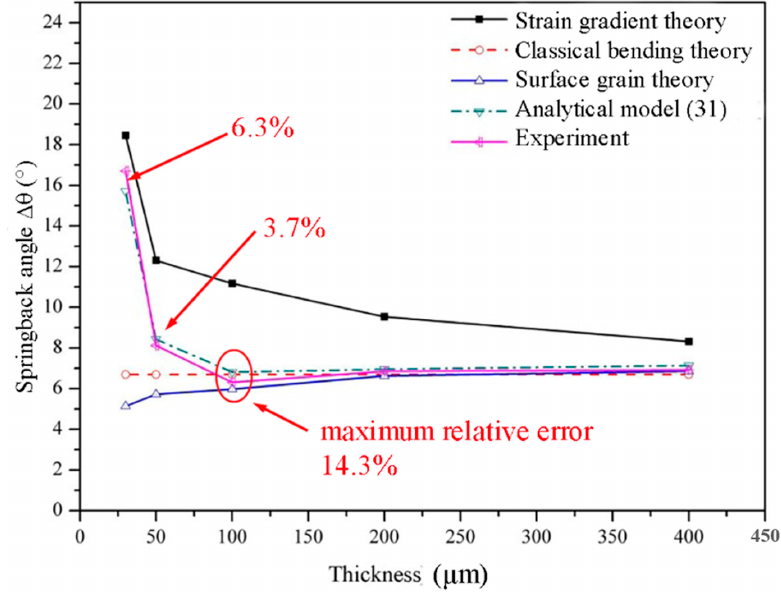
Figure 9. Comparison of calculation values by four methods and experimental